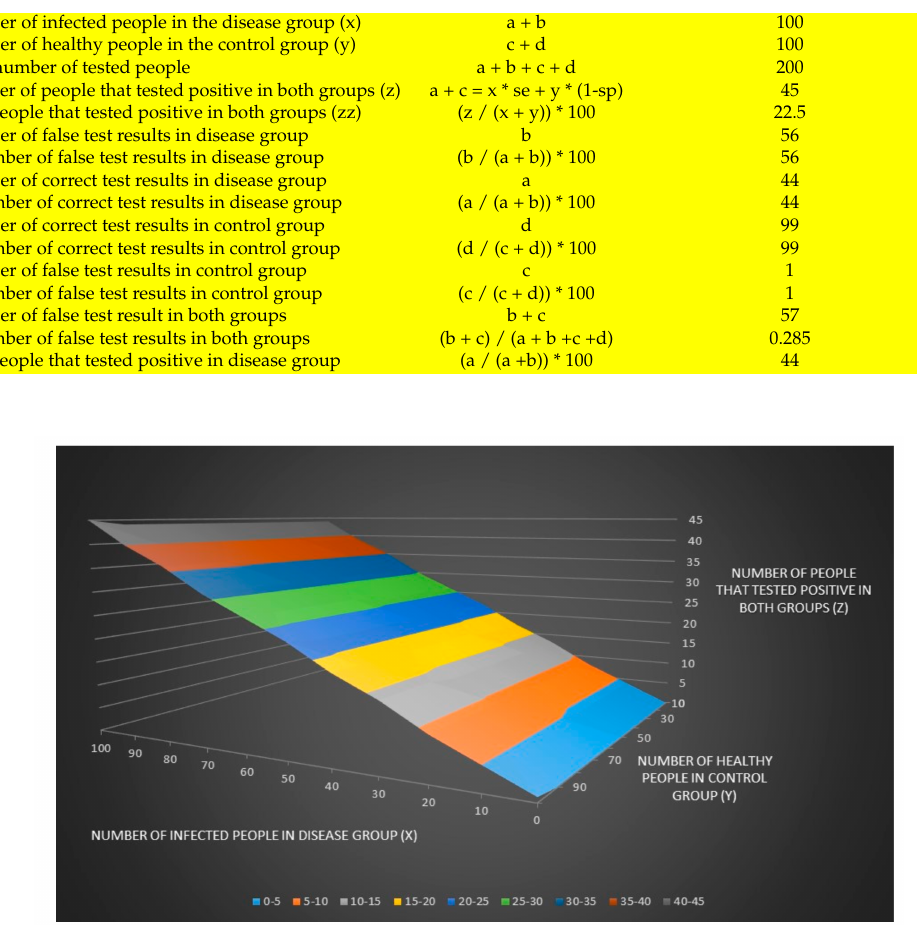
Figure 1. The number of people that tested positive in both groups (z) when the number of infected people in the disease group (x) and the number of healthy people in control groups (y) are unknown.